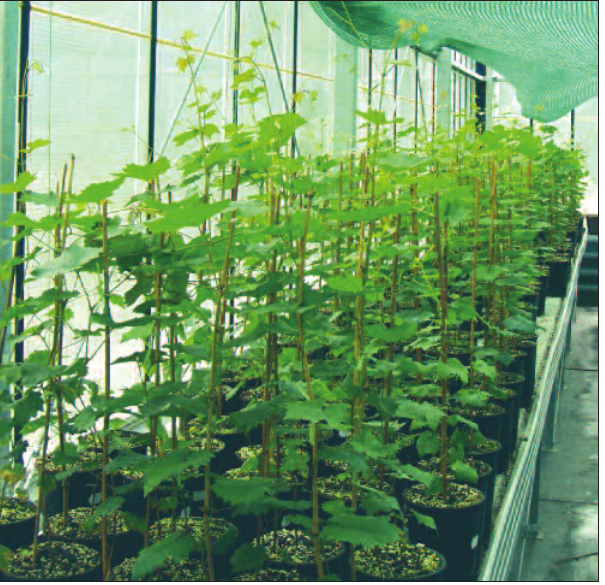
Figure 3. Acclimatized in vitro grapevine plants started from shoot tip